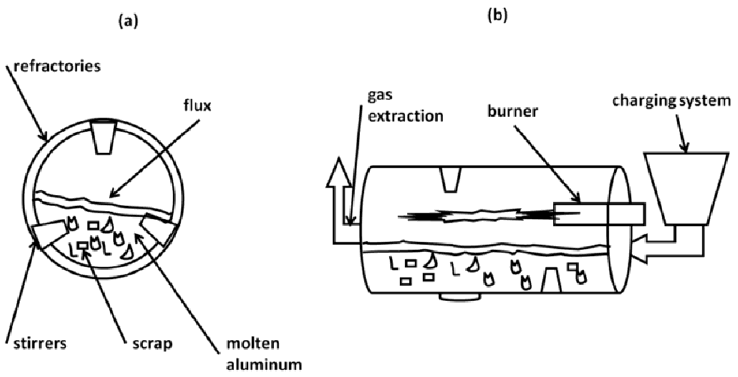
Figure 12. Draft of a rotary furnace: ( a ) frontal and ( b ) lateral